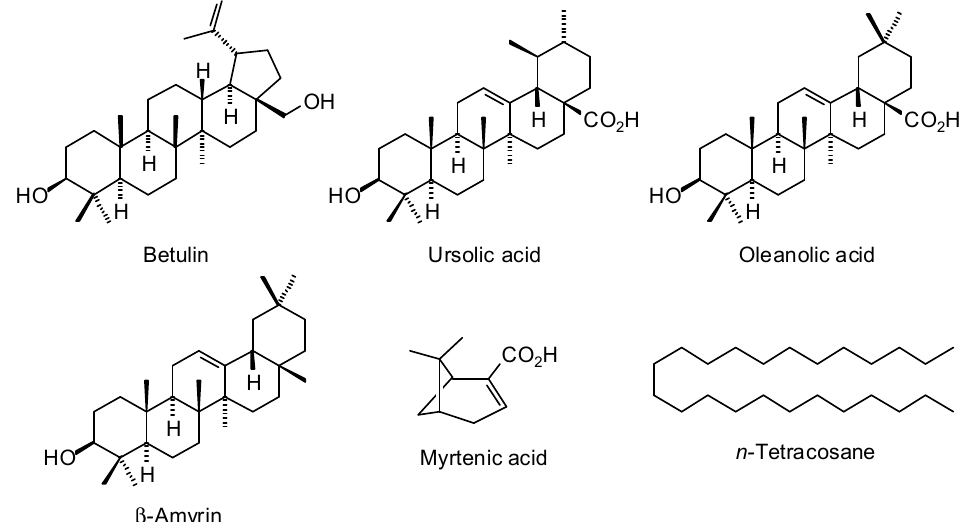
Figure 3. Chemical structures of nonvolatile components isolated from Conradina canescens .